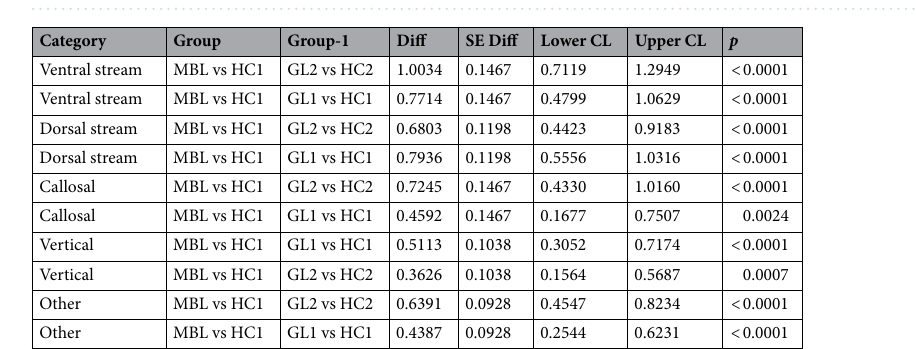
Figure 3. Effect size on the white matter microstructure across tract categories. ( a ) Fractional anisotropy (FA). ( b ) Mean diffusivity (MD). The effect of glaucoma and monocular blindness on the WMM compared to healthy controls is visualized for each tract category (abscissa) and participant groups (colors). Positive effects sizes indicate that the microstructural estimate (of either FA or MD) was increased in the clinical group as compared to the healthy controls. Asterisks indicate significance for the comparisons between conditions (colors) with Bonferonni corrected p values ( p < 0.05/21 (category*group) = p < 0.0024). The color of the asterix indicates conditions (colors) were different.